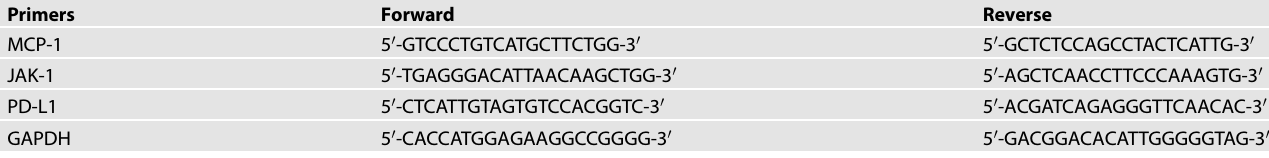
Table 2. The primers used in the RT-qPCR